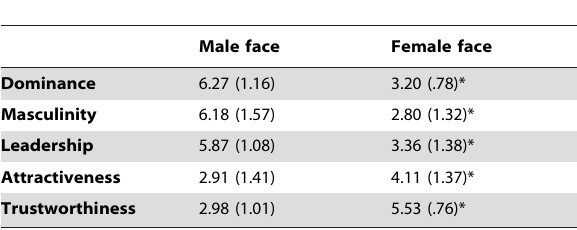
Table 1. Mean Rating Scores and Standard Deviations of The Male and Female Face on Various Features (1=high degree, 7=low